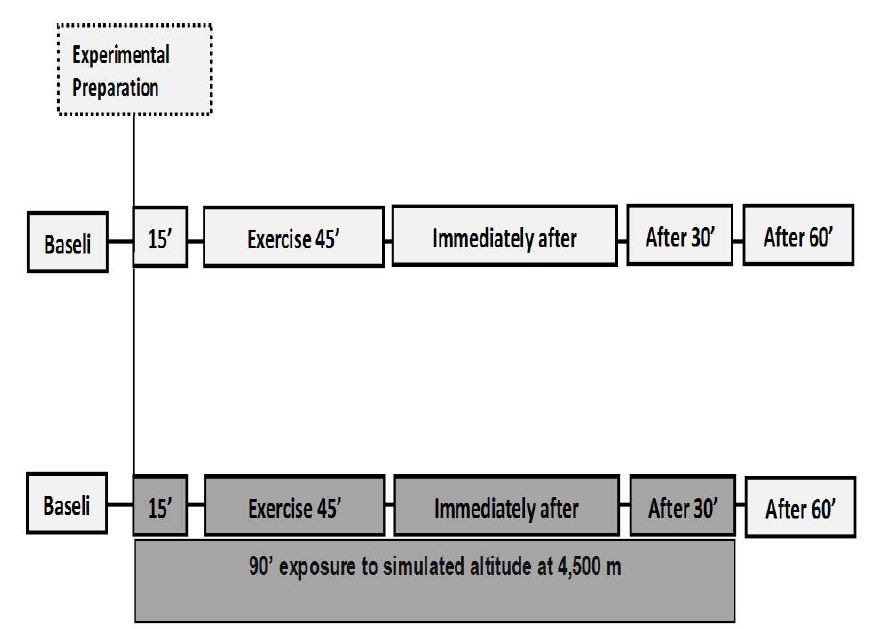
Figure 1. The timeline depicts the experimental design performed by n = 10 volunteers subjected to two conditions: a normoxic condition (NC) and a hypoxic condition (HC) similar to 4,500 m altitude for 90 minutes. For 15 min, the volunteers were allocated to a chamber that simulated altitude. After adjustment, a session of exercise was performed for 45 min. Evaluations of mood state and anxiety symptoms were conducted at four time points: a baseline evaluation outside the chamber in normoxic condition; immediately after 45 min of exercise under the hypoxic con- dition; after 30 min of exercise under the hypoxic condition; and after 60 min outside the altitude-simulator chamber under a normoxic